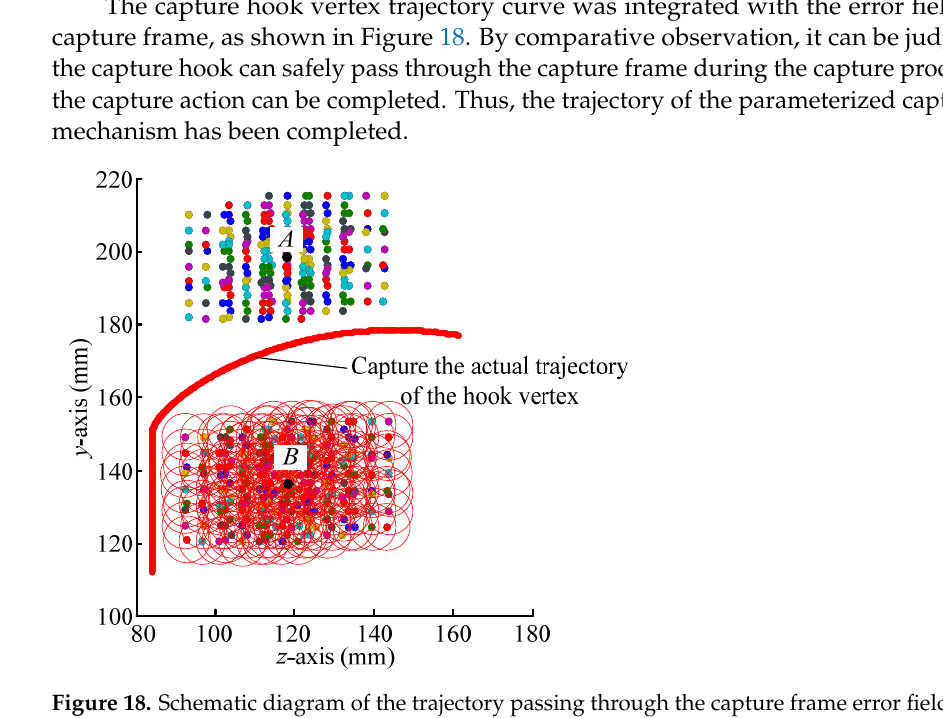
Figure 18. Schematic diagram of the trajectory passing through the capture frame error field. ( A : The top plate center of capture frame; B : The positioning shaft center of capture frame.)